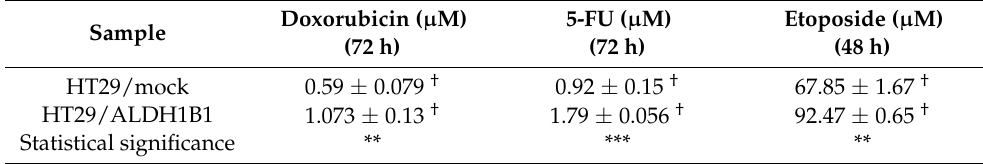
Table 5. EC 50 values of doxorubicin (72 h), fluorouracil (5-FU) (72 h) and etoposide (48 h).